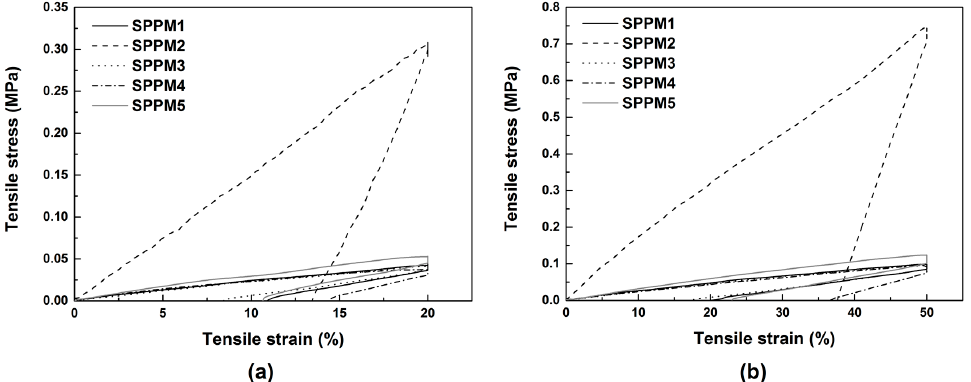
Figure 6. Typical stress vs. strain relationships of all samples programmed with 20% strain ( a ) and 50% strain ( b ).